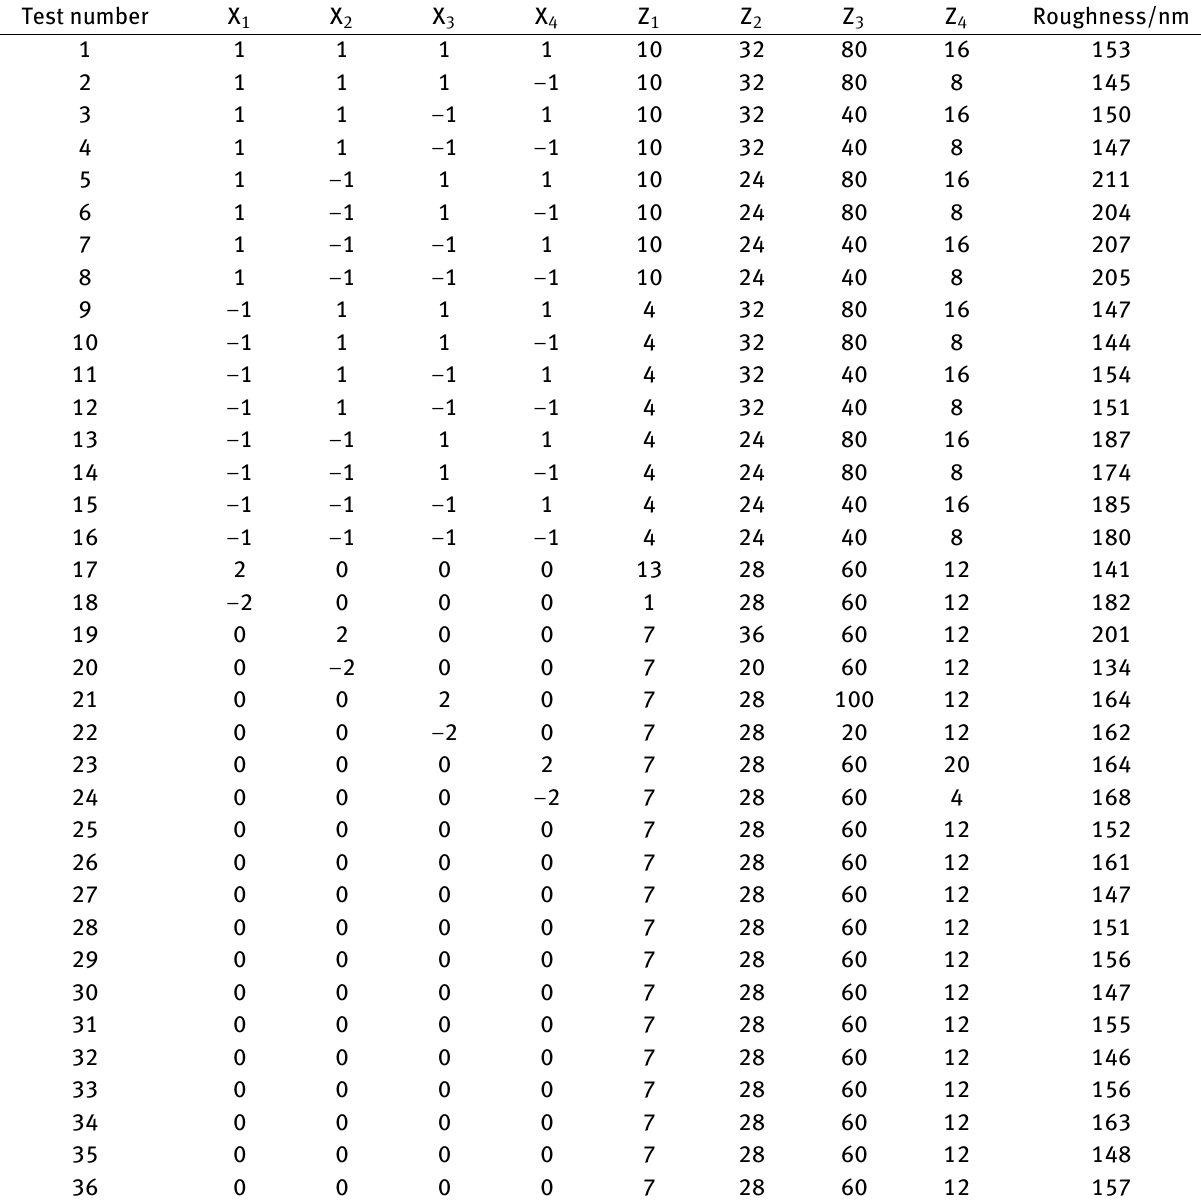
Table 5: Design and test results of quadratic orthogonal rotation combination